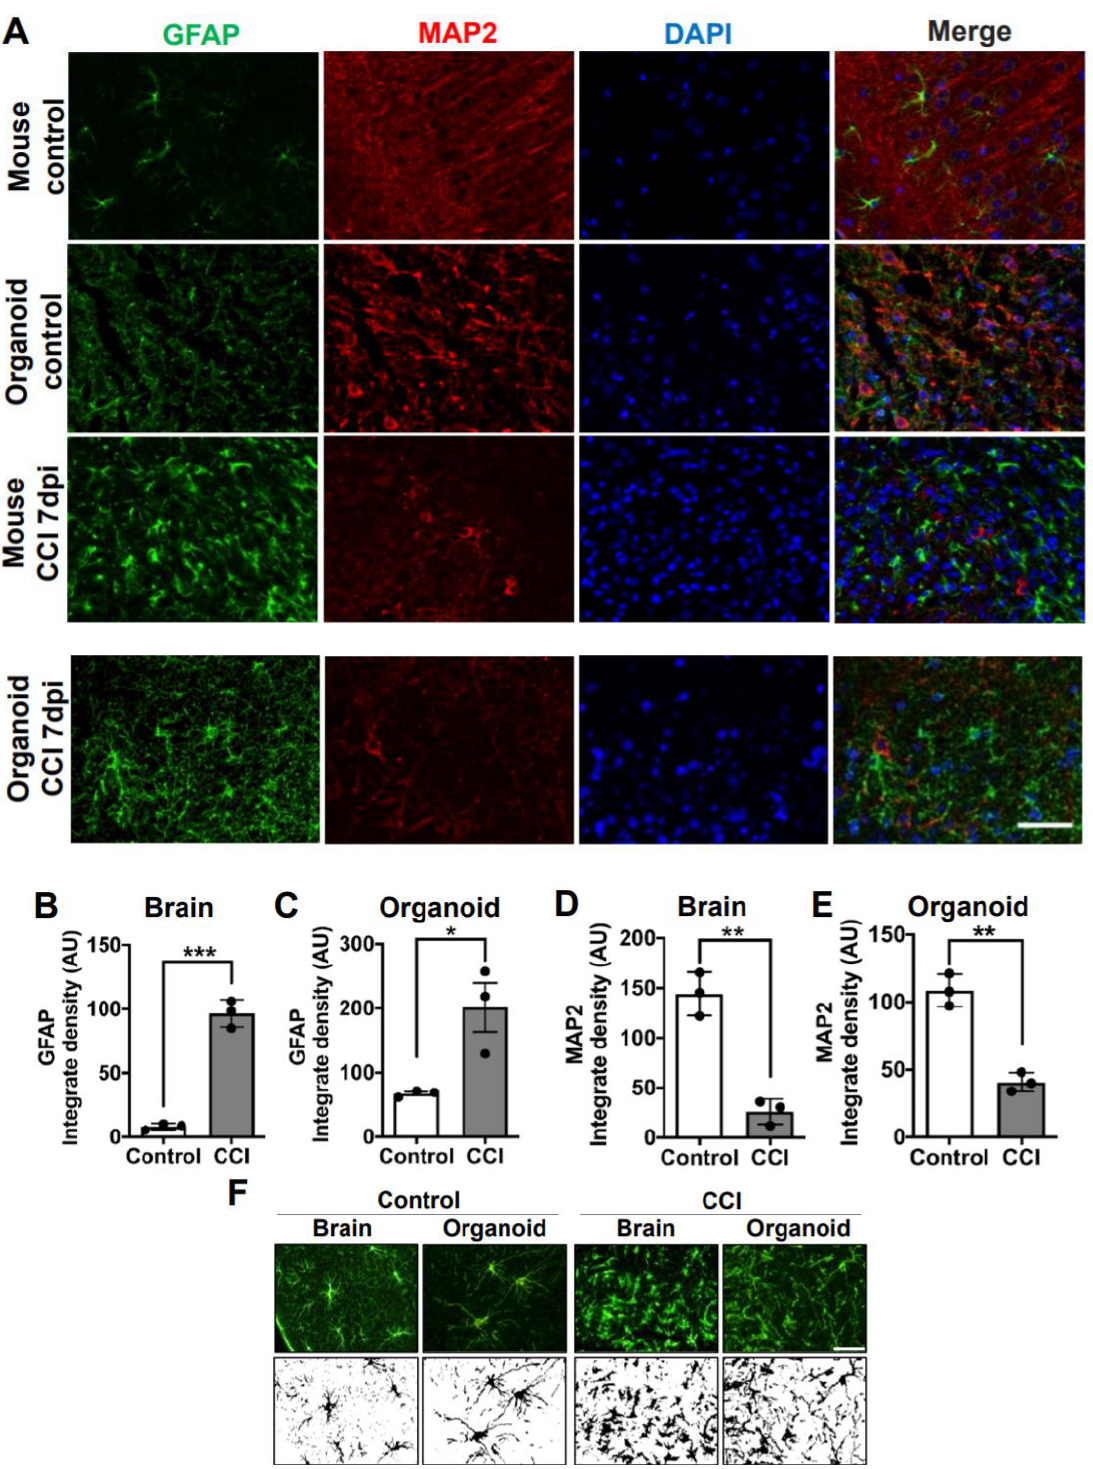
Figure 3. Astrogliosis and reduction of neurons in COs after CCI. ( A ) Microphotographs of COs and mice brain subjected to CCI stained with GFAP and MAP2 antibodies to recognize astrocytes and neurons, respectively. Immunostaining was done 7 days after CCI. ( B ) Immunofluorescence quantifications of GFAP in mouse brain (Controls 8.241 ± 2.5 vs. CCI 96.68 ± 10.7; p = 0.0002) and ( C ) COs (Controls 67.31 ± 5.0 vs. CCI 201.6 ± 65; p = 0.0241). MAP2-positive neuronal density in ( D ) mouse brain (Control 144.2 ± 21.7 vs. CCI 26.24 ± 12.5; p = 0.0012) and in COs ( E ) (Control 108.7 ± 11.9 vs. CCI 40.73 ± 7.0; p = 0.001). ( F ) Morphological changes in astrocytes of COs and mouse brains were observed 7 days after CCI. Magnification: X40, scale bars = 50 μm. Statistical analysis performed with Student’s t -test, * p ≤ 0.05; ** p ≤ 0.01; *** p ≤ 0.001.